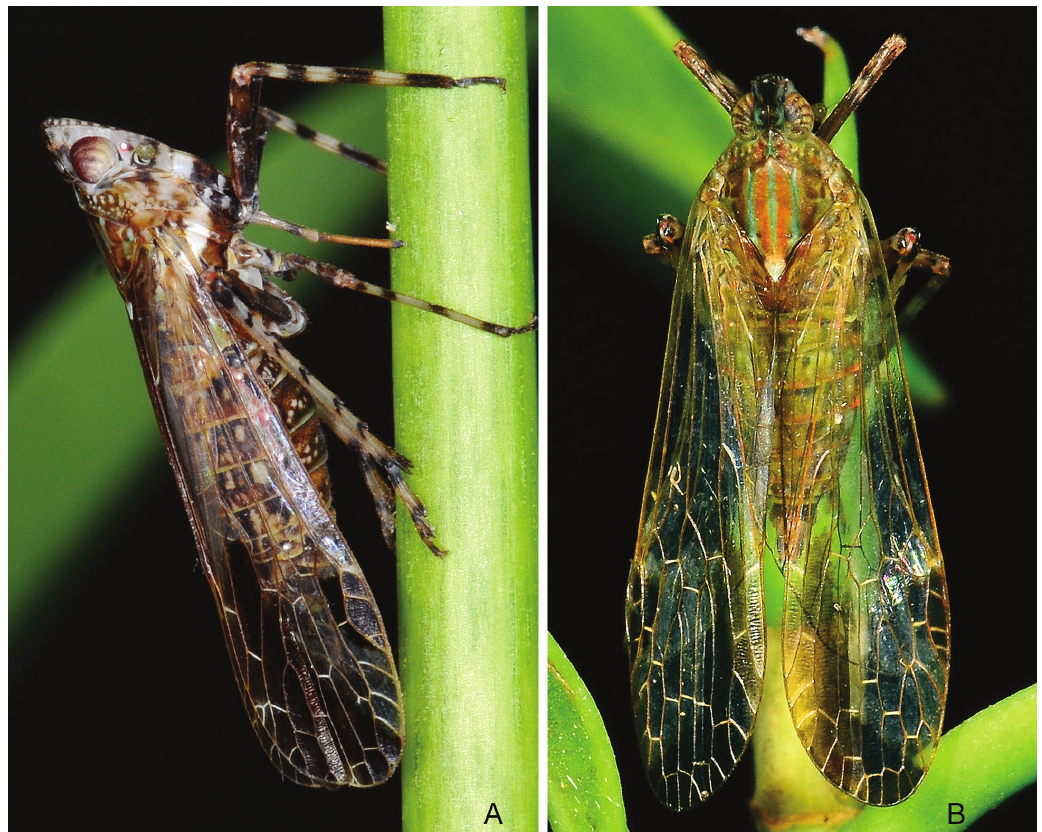
Figure 1. ( A ) Orthopagus lunulifer Uhler, female, Henan, China; ( B ) Orthopagus splendens (Germar), male, Yunnan, China. Photo- graphed by Z.-S.